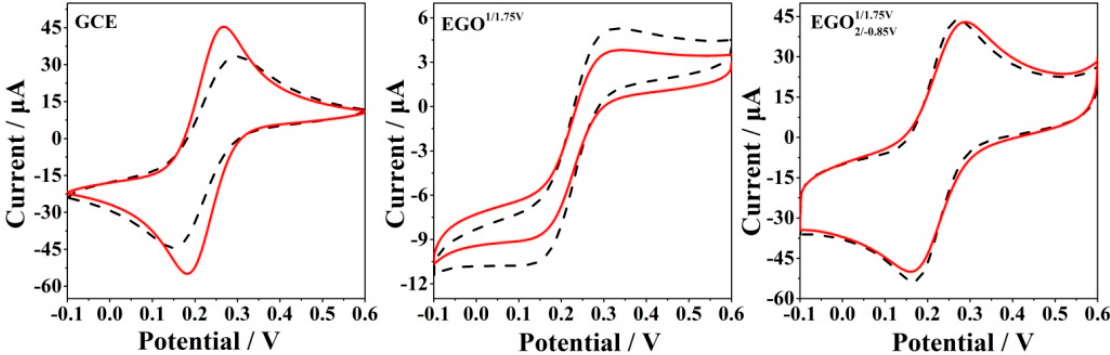
(cid:2876)(cid:2873)(cid:2906)(cid:2869) / (cid:2869) . (cid:2875)(cid:2873)(cid:2906) in the presence (dashed line) and absence in the presence (dashed line) and absence 2/ − 0.85V (cid:2870) / (cid:2879)(cid:2868) .